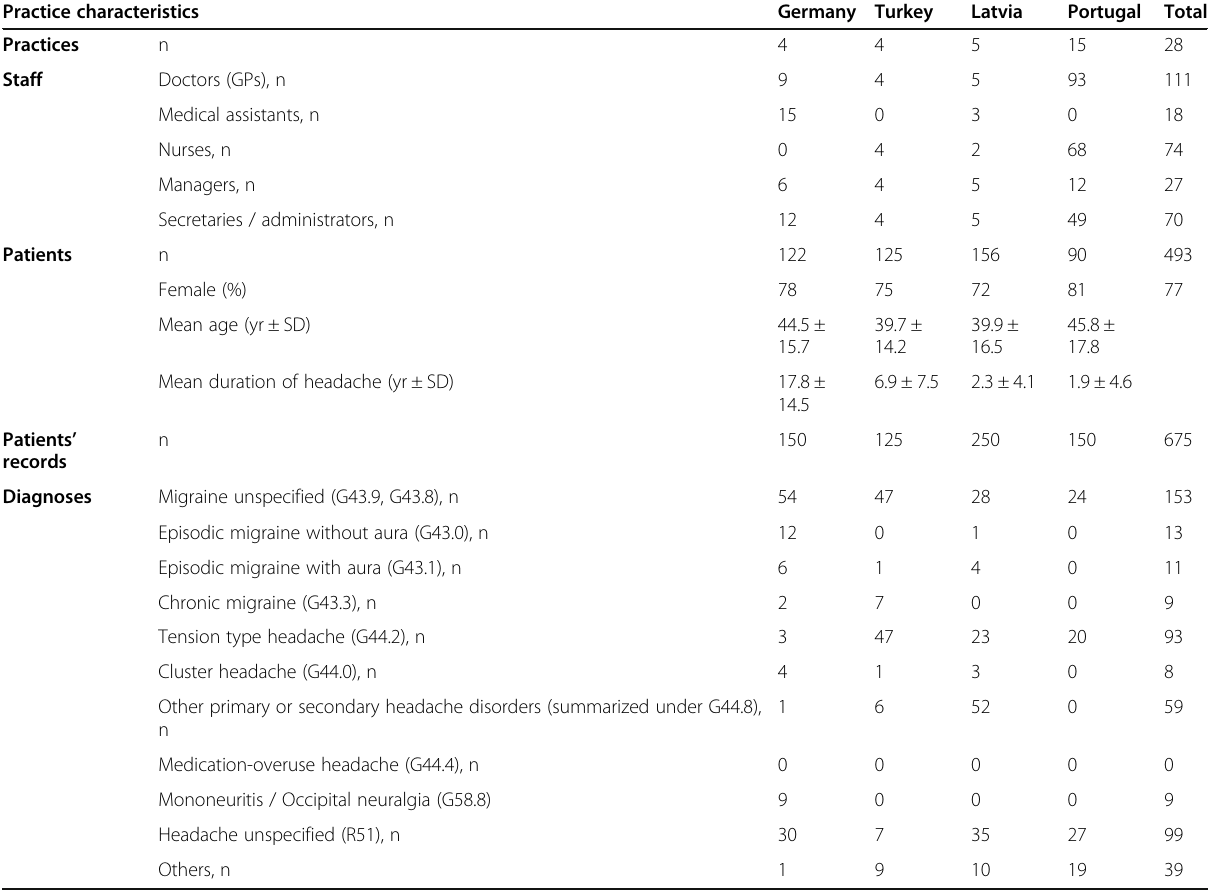
Table 2 Characteristics of participating primary-care practices Practice